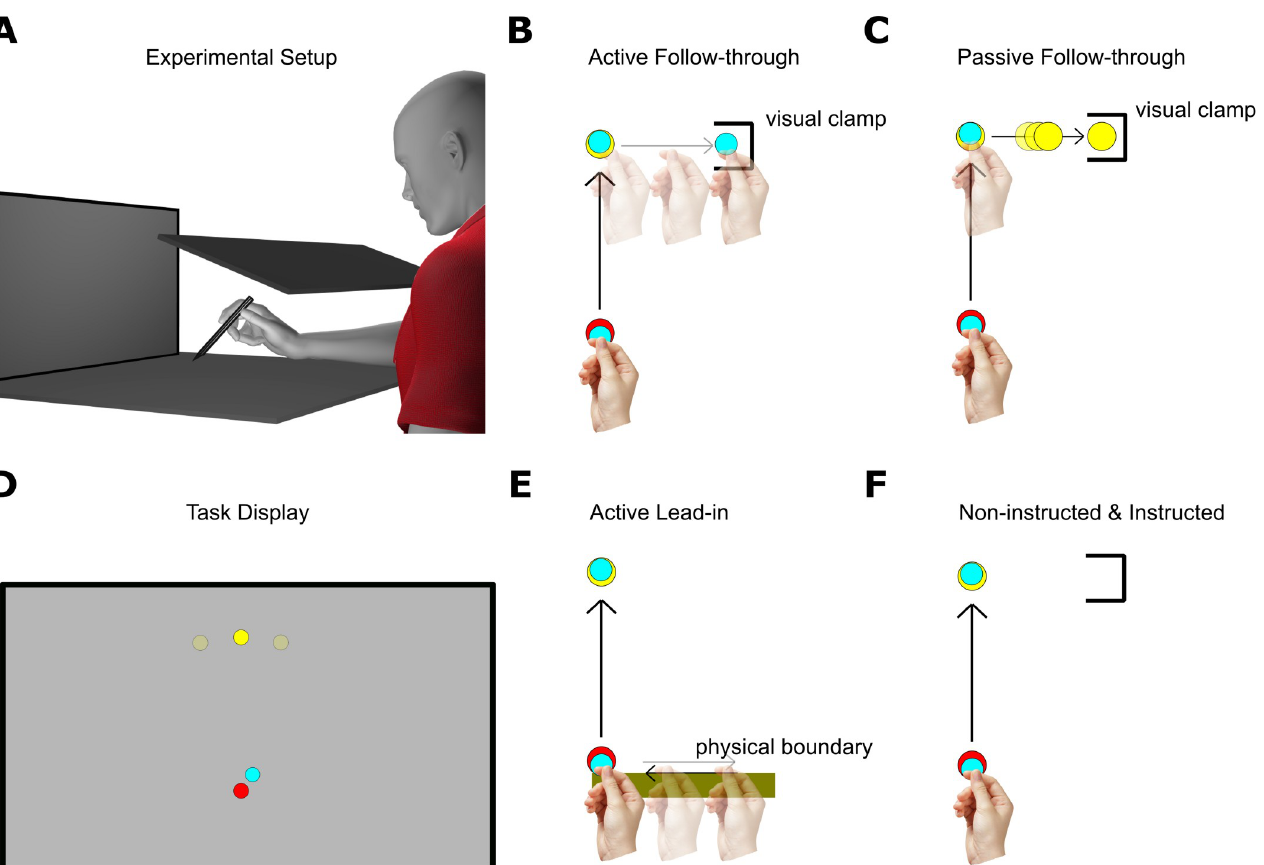
Fig 1. Experiment setup and task schematic. A. Participants reached along a horizontally-placed digitizing tablet. An opaque shield occluded the view of their hand. Participants viewed the motion of their hand-cursor on a monitor located at the end of the tablet. B. For Experiment 1a, those in the Active Follow- through condition reached to the yellow target disc, immediately followed by a visually-clamped reach to the box target. CW-only and CCW-only control groups completed the same task but only experienced a single perturbation. C. In the Passive Follow-through condition, participants reached to the yellow target disc, stopped, and only viewed the yellow target disc move to the target box. D. Participants saw targets discs located at one of three positions. E. For Experiment 1b, participants made an unseen reach along a solid edge to the left or right (brown bar), returned to the home position, and then to the yellow target disc, completing a three-part sequence. F. For experiment 2, those in the Non-instructed condition only reached to the yellow target disc, while they saw target boxes that indicated the perturbation in that trial. Those in the Instructed condition performed this same task but were instructed with a compensatory strategy.